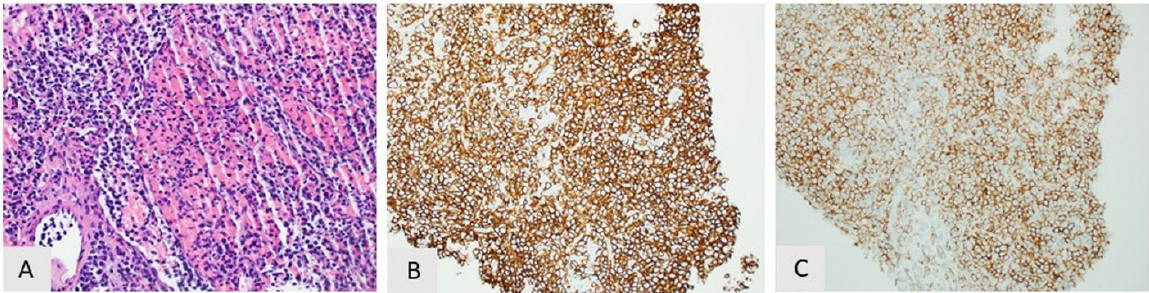
Figure 5. Hairy cell leukemia variant, spleen. ( A ) Red pulp involvement with intrasinusoidal growth pattern, H&E, 20 × ; by immunohistochemistry the cells are positive for ( B ) CD20 and ( C ) CD103, but negative for CD25, annexin A1, CD 123, and BRAF V600E (not shown).